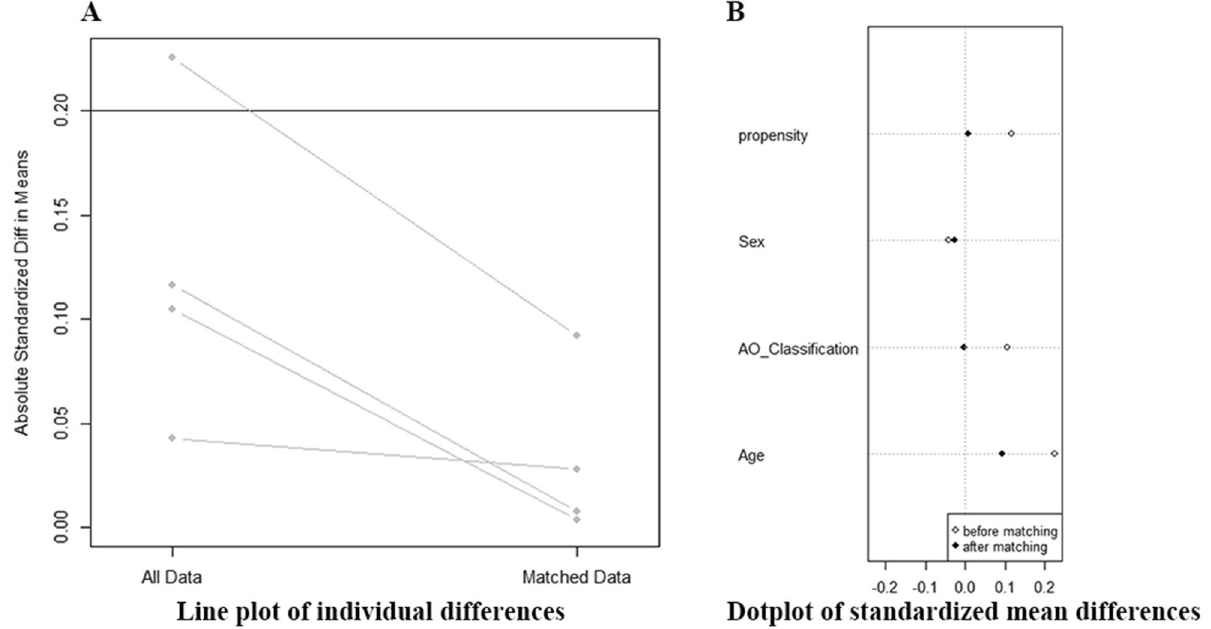
Figure 2. Evaluation of outcome of propensity score matching (PSM).